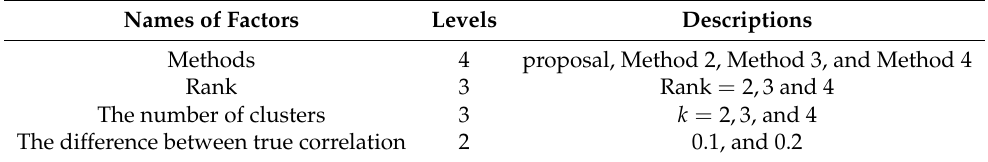
Table 1. Summary of simulation